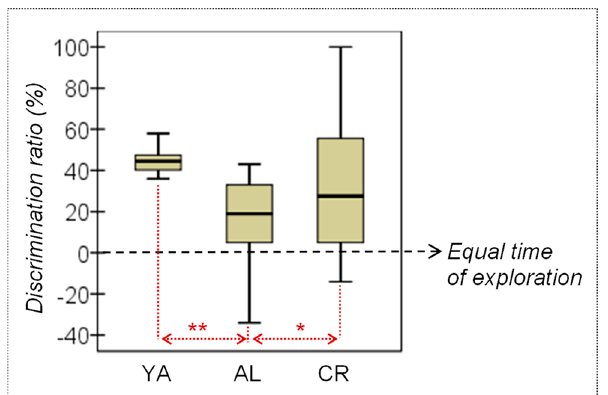
Figure 3. YA, young adult; AL, ad libitum; CR, caloric restriction. * Mild–moderate effect size (| d | > 0.50); ** Large–high effect size (| d | >